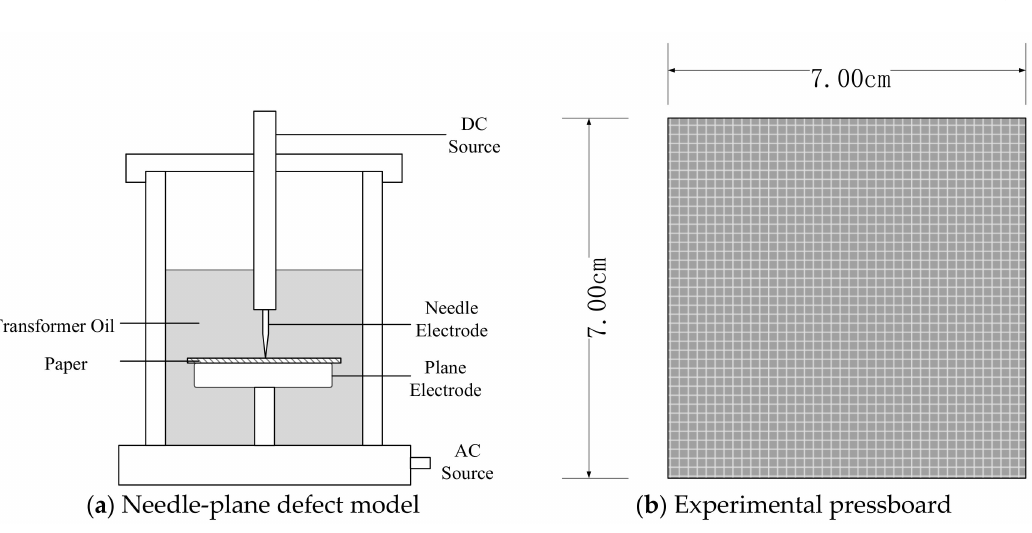
Figure 1. Experimental